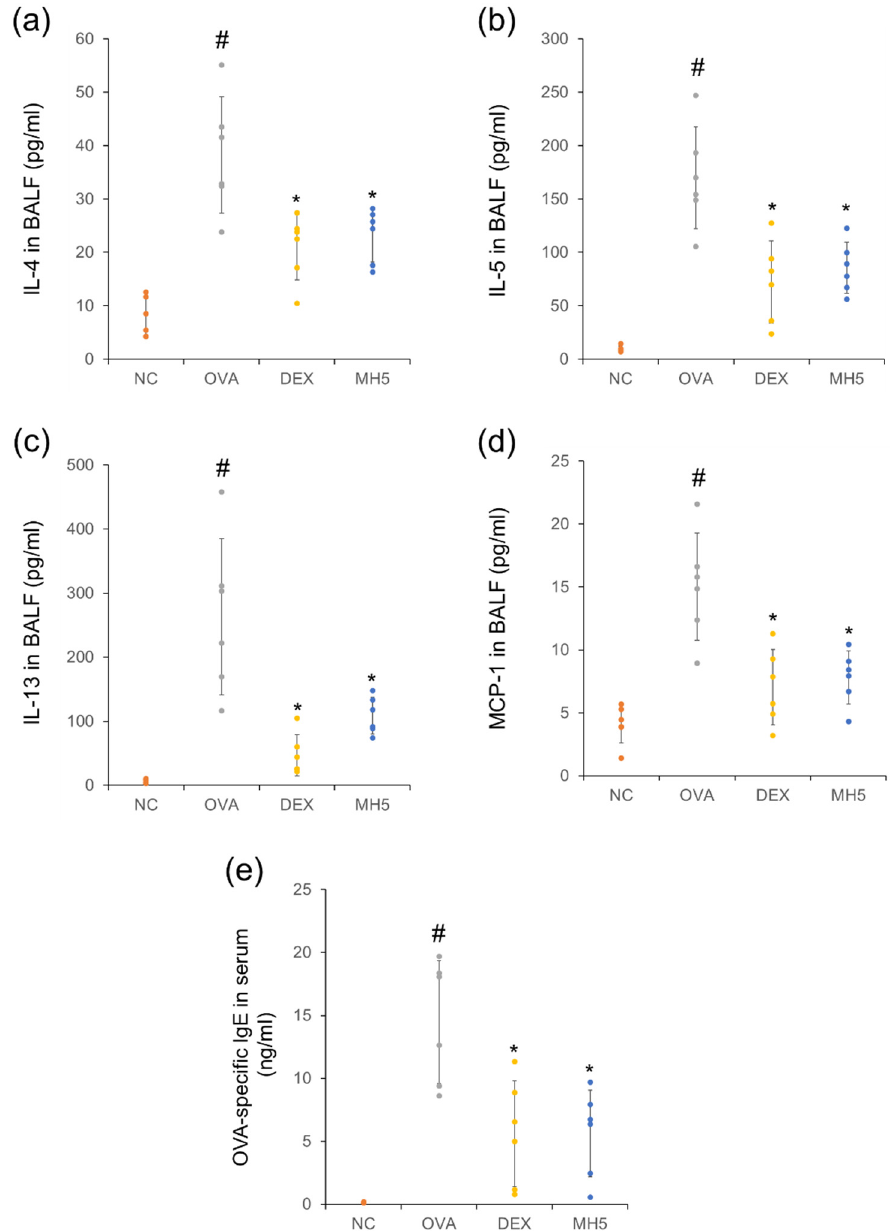
Figure 7. Effects of MH on the production of Th2 cytokines, MCP − 1, and IgE in mice with AA. ( a – d ) The levels of Th2 cytokines (IL − 4, − 5, and − 13) and MCP − 1 in BALF were determined using ELISA assays. ( e ) The level of OVA − specific IgE in the serum was determined using ELISA assays. Data are expressed as the mean ± SD ( n = 6) ( # p < 0.05 for comparison with normal control; * p < 0.05 for comparison with OVA